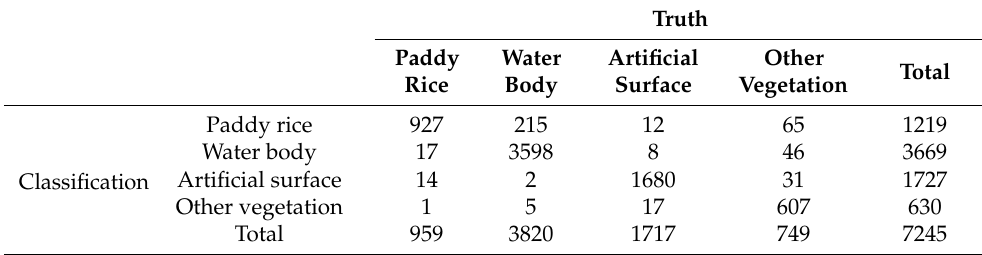
Table 8. Confusion matrix of the CART model under POI